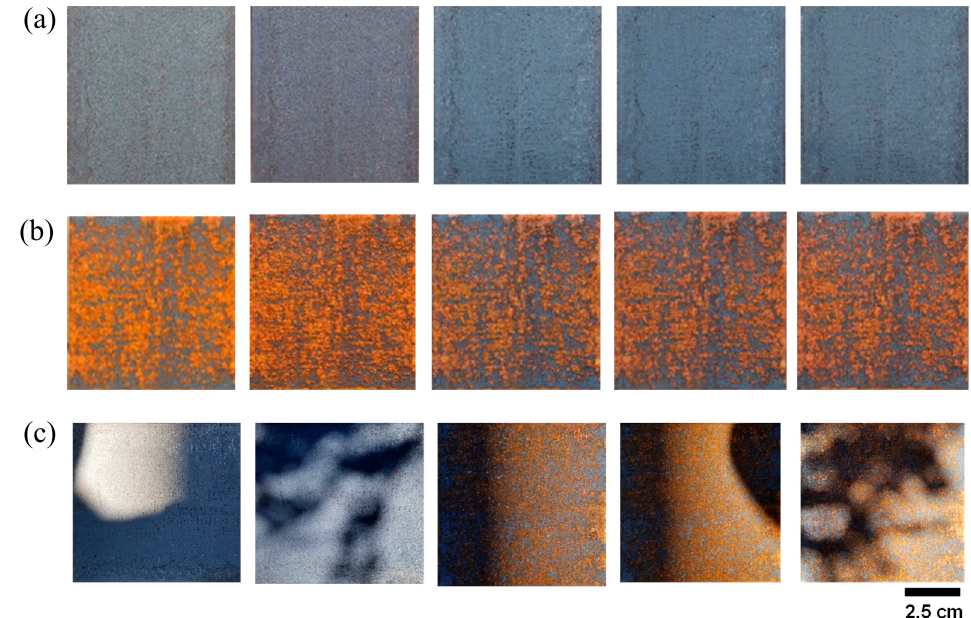
Figure 1. Non-corroded and corroded steel plates used for training purposes. ( a ) top row (left to right) includes images of non-corroded plates acquired at varying illuminations under natural daylight, ( b ) second row (left to right) includes images of corroded plates acquired under illuminations similar to that of non-corroded plates and, ( c ) third row (left to right) includes images of both corroded and non-corroded plates acquired under casted shadows.